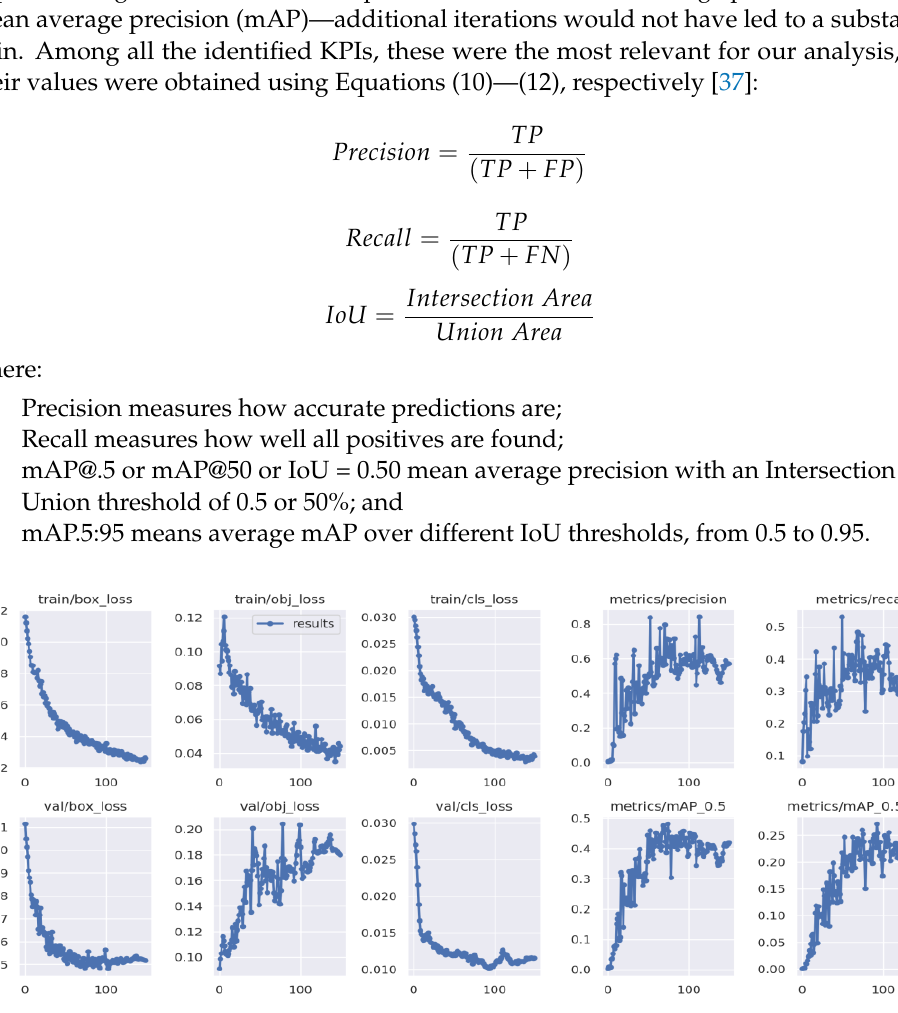
Table 7. Training configuration.